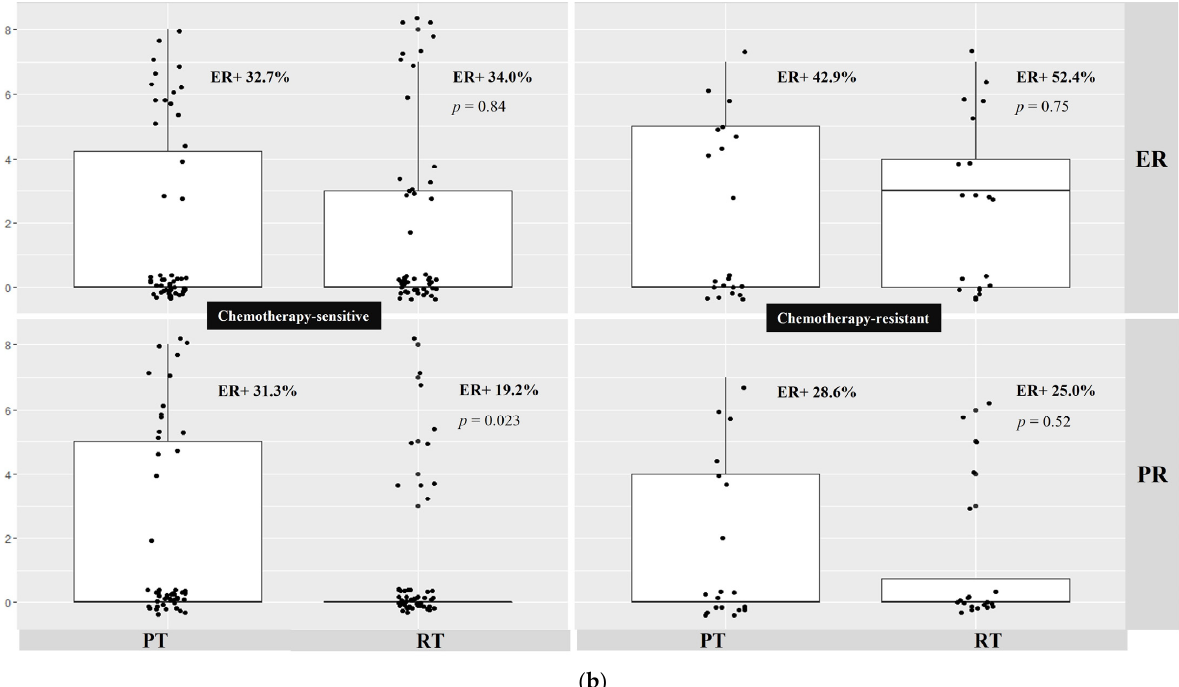
Figure 1. ( a ) Association of estrogen and progesterone receptor immunoexpression between primary and recurrent tumors (Immuno-reactive Score System); ( b ) Association of estrogen and progesterone receptor immunoexpression between primary and recurrent tumors (Allred Total Score System). ( a ) shows the distribution of Immunoreactive Score for estrogen and progesterone receptor expres- sion in primary and paired recurrent HGSOC. ER, estrogen receptor; PR, progesterone receptor; PT, primary tumor; RT, paired recurrent tumor; HGSOC, high-grade serous ovarian cancer; IRS, Immunoreactive Score. There was a statistically significant lower PR expression in chemotherapy- sensitive-matched primary and recurrent HGSOC. ( b ) shows the distribution of Allred Total Score for estrogen and progesterone receptor expression in primary and paired recurrent HGSOC. ER, estrogen receptor; PR, progesterone receptor; PT, primary tumor; RT, paired recurrent tumor; HGSOC, high-grade serous ovarian cancer; ATS, Allred Total score. Progesterone receptor expression was statistically significantly lower in chemotherapy-sensitive-matched primary and recurrent